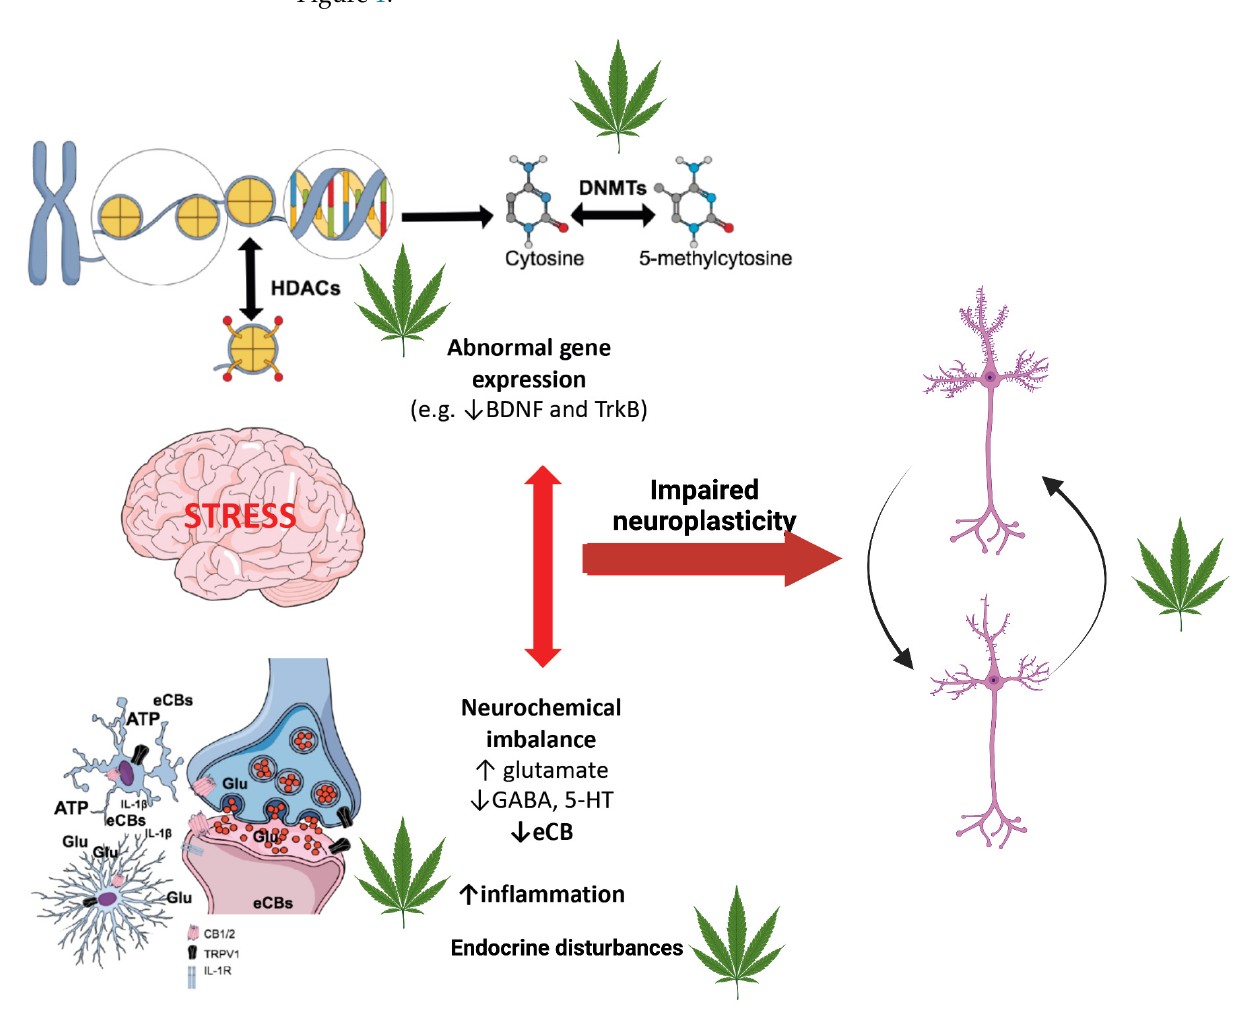
Figure 1. Overview of cannabis interactions with epigenetic mechanisms in relation to molecular alterations caused by stress. Stress is the main environmental factor increasing vulnerability to depression by causing dysregulation of several neurotransmitter systems (monoamines, endocannabinoids, glutamate, GABA), increased neuroinflammation, endocrine disturbances and impaired neuroplasticity, which result in impaired adaptation to subsequent aversive life events and depressed mood. All these mechanisms can be regulated by epigenetic changes, such as histone modifications (e.g. by HDACs), and DNA methylation (by DNMTs) since they exert transcriptional control over synthesizing and degrading enzymes, transporters, receptors, neurotrophins, synaptic proteins and inflammation mediators. Conversely, since the epigenetic machinery is regulated by neuronal activity, it can be directly influenced by brain’s neurochemical milleu. Cannabis, through its major constituents (CBD and THC), can “erase” stress-induced epigenetic changes by targeting neurotransmitter receptors and the neurochemical milleu, or by directly regulating the activity of DNMTs and other